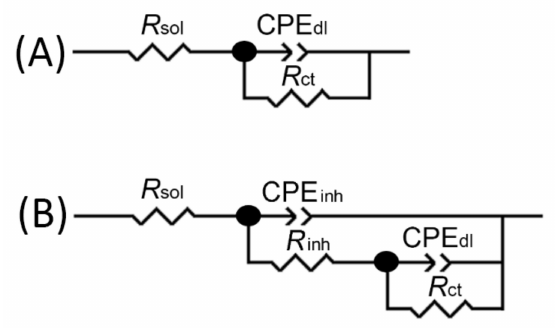
Figure 10. Equivalent circuits used for numerical simulation of the EIS data: ( A ) equivalent circuit with 3 elements, ( B ) equivalent circuit with 5 elements.